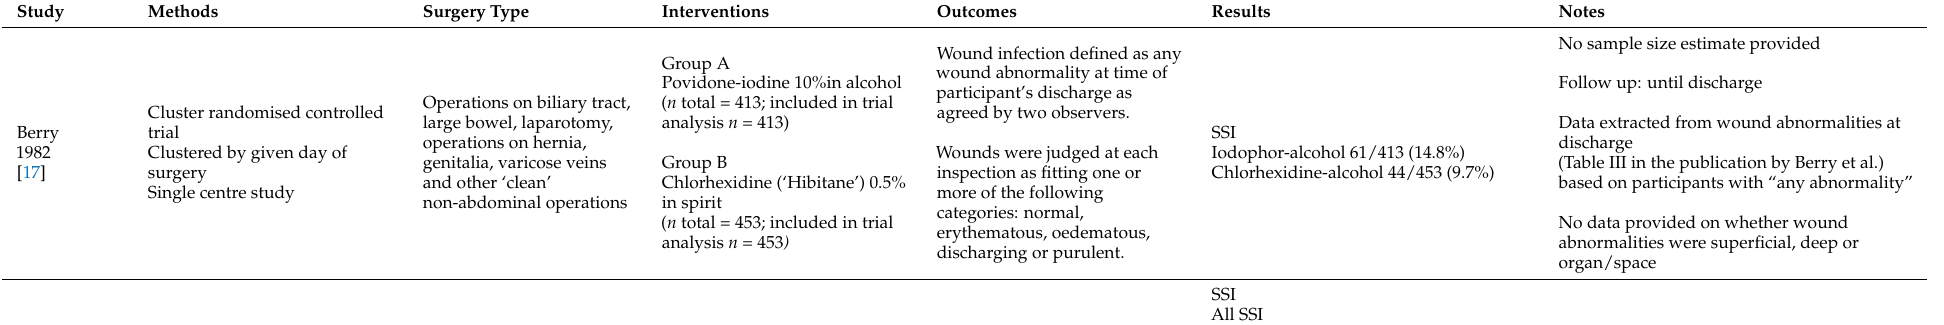
Table 1. Characteristics of Included